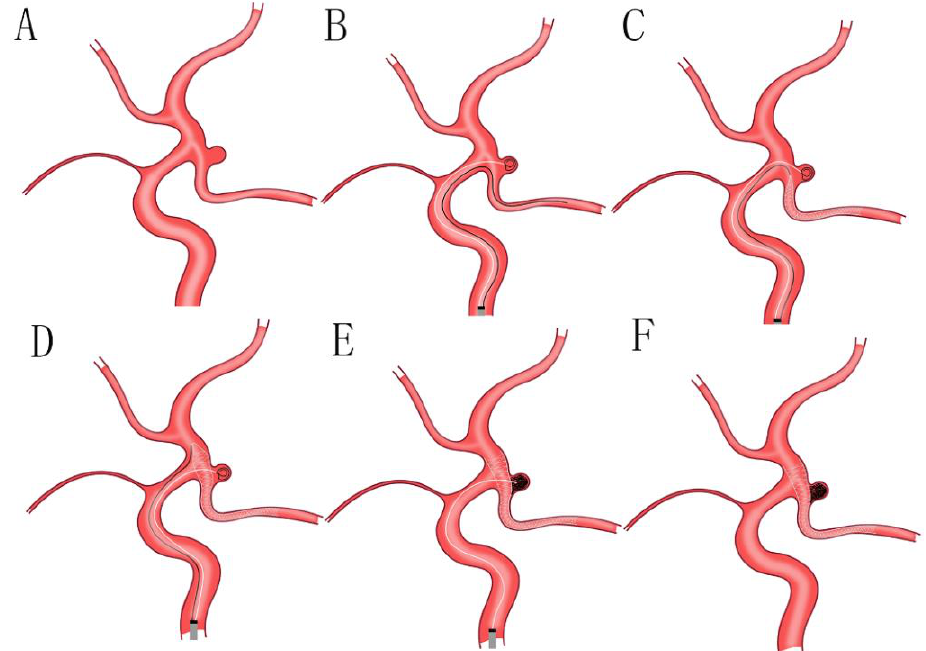
Figure 2. ( A ): A suitable stent was selected, according to the characteristics of aneurysms and the parameter of parent arteries, as assessed by intraprocedural DSA; ( B ): a suitable stent microcatheter was navigated to the ipsilateral PCoA, and a suitable coil microcatheter was navigated to the aneurysmal lumen and transported several coils loosely, via the ipsilateral ICA; ( C ): the stent microcatheter was withdrawn, and the stent was gradually released in the PCoA until the tip of the stent microcatheter arrived at the ostium of the PCoA in ipsilateral ICA; ( D ): the stent microcatheter was pushed, and the stent was released in the distal segment of the ipsilateral ICA completely, with complete coverage of the aneurysmal neck; the good wall apposition of the stent was confirmed by intraprocedural DSA, and was used to remove the stent microcatheter from the guiding catheter; ( E ): to transport several coils via a suitable coil microcatheter with the assistance of stent, and to accomplish the complete occlusion of an aneurysm confirmed by intraoperative DSA; ( F ): to withdraw the coil microcatheter and guiding catheter from the vessel. DSA: digital subtraction angiography; PCoA: posterior communicating artery; ICA: internal carotid